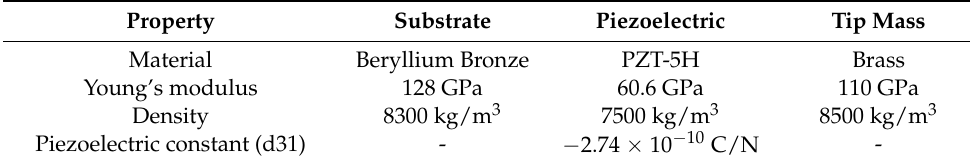
Table 2. Material parameters of the proposed